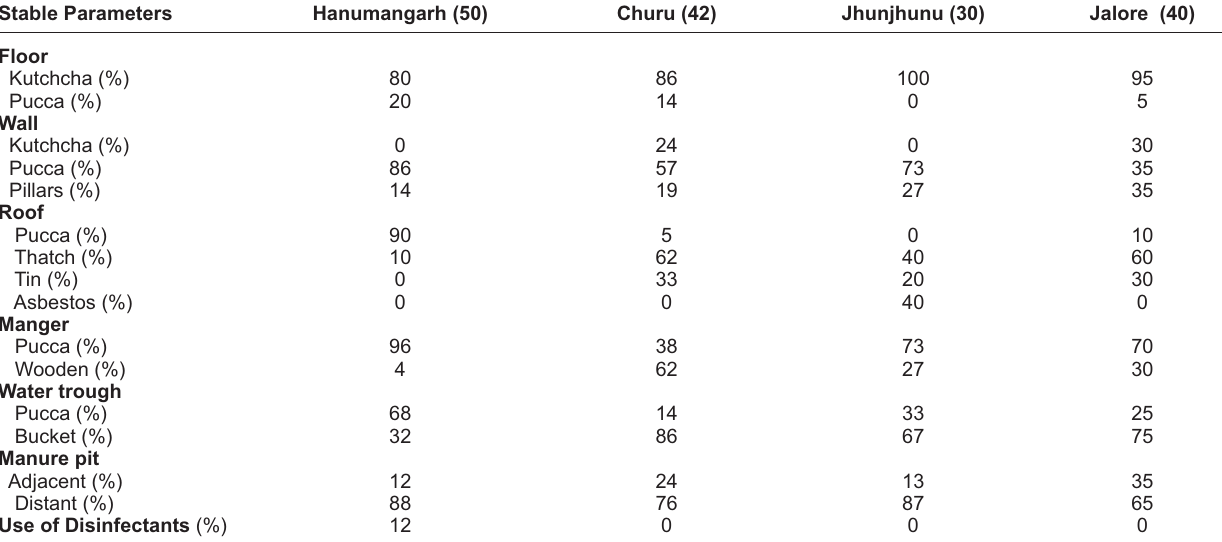
Table-3. Housing management of horse in four districts of Rajasthan Stable